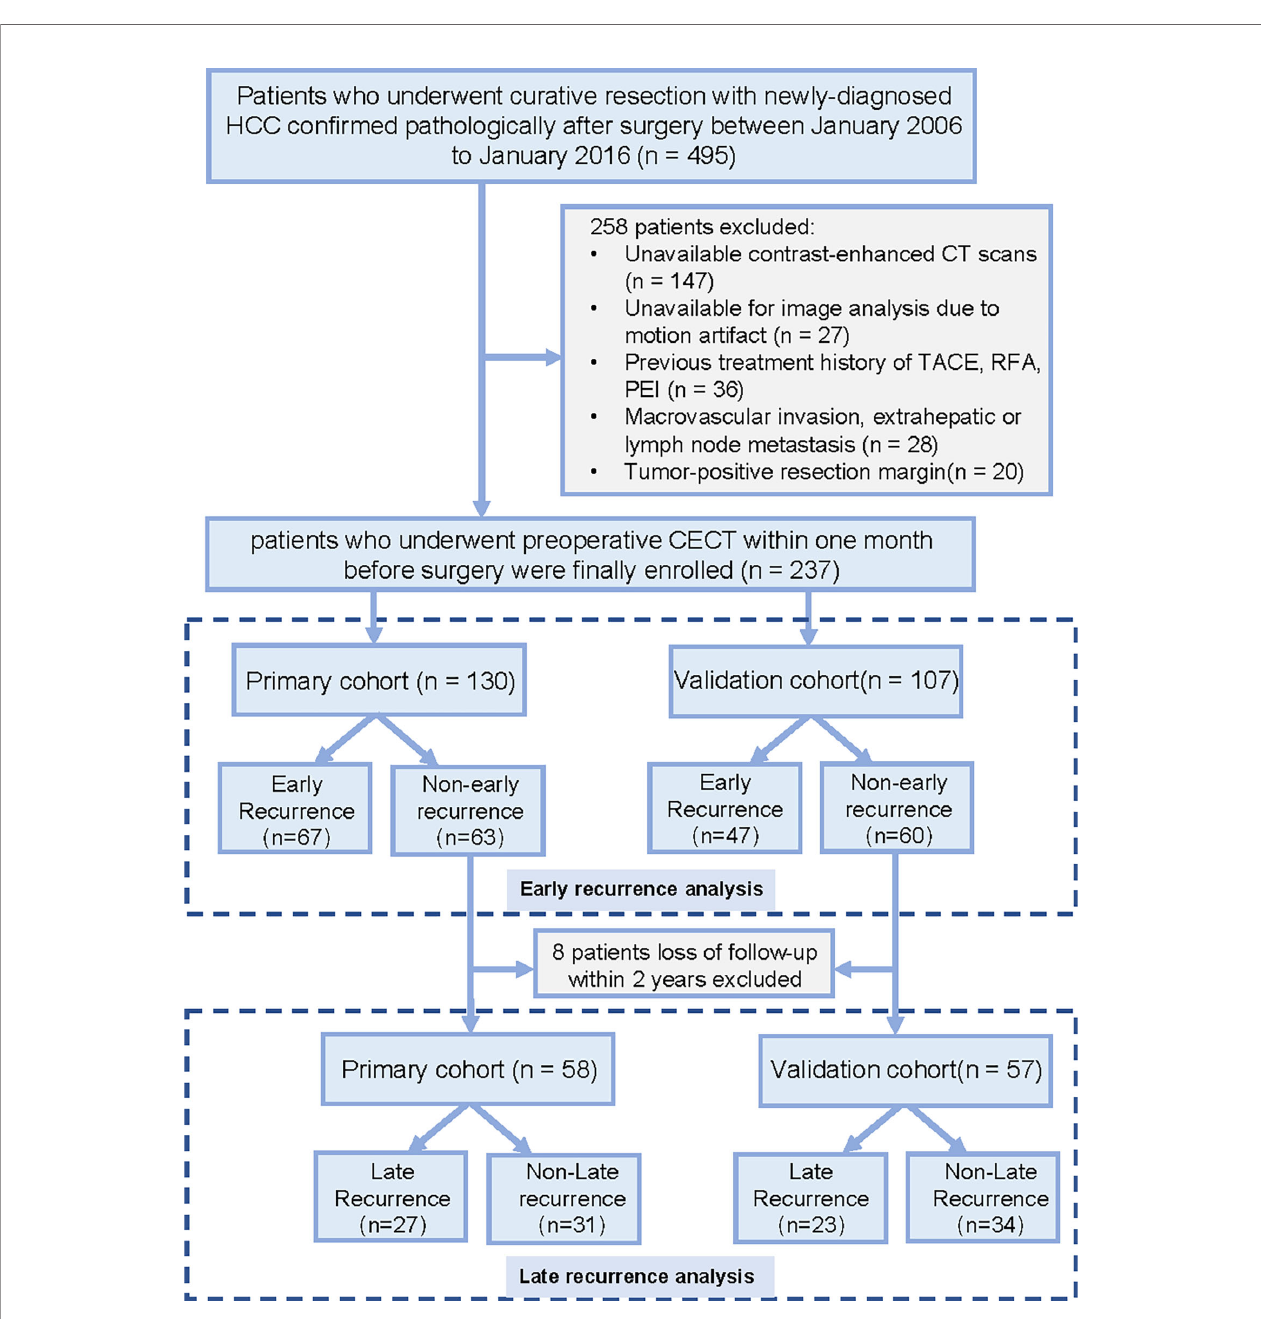
FIGURE 1 | Recruitment pathway for patients in this study. HCC, hepatocellular carcinoma; CT, computed tomography; TACE, transarterial chemoembolization; RFA, radiofrequency ablation; PEI, percutaneous ethanol